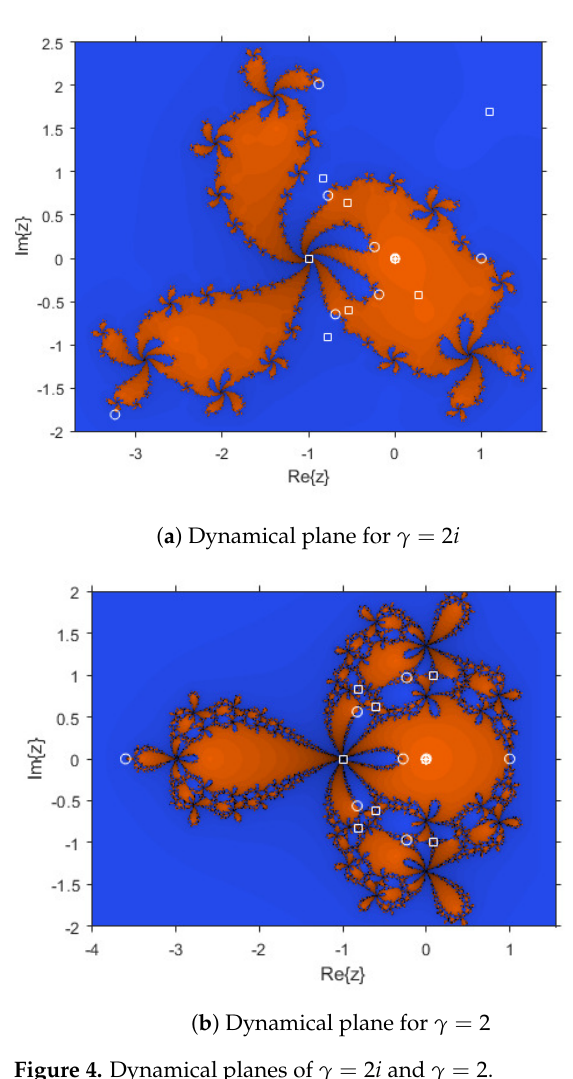
Figure 4. Dynamical planes of γ = 2 i and γ =